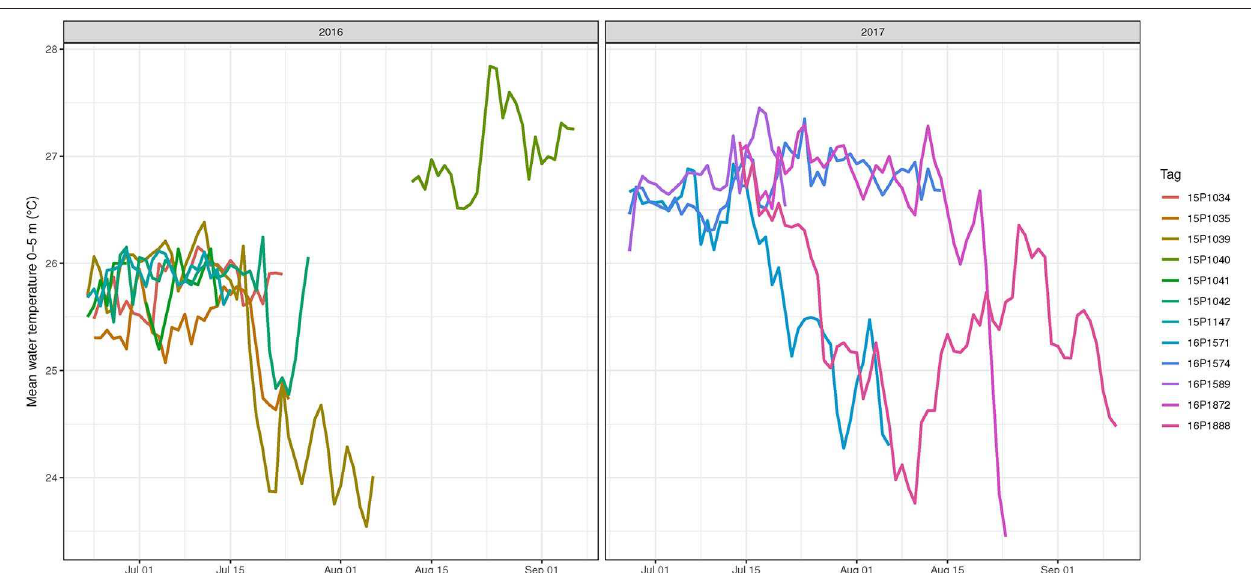
FIGURE 4 | Mean water temperatures at 0–5m as experienced by tagged yellowfin tuna in 2016 and 2017. For each fish (color coded), temperatures were summarized daily.